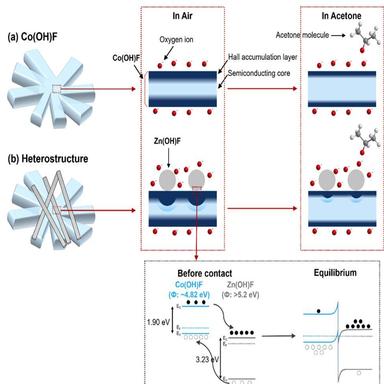
Schematic of the gas-sensing mechanism of (a) pristine Co(OH)F, and (b) heterostructures.